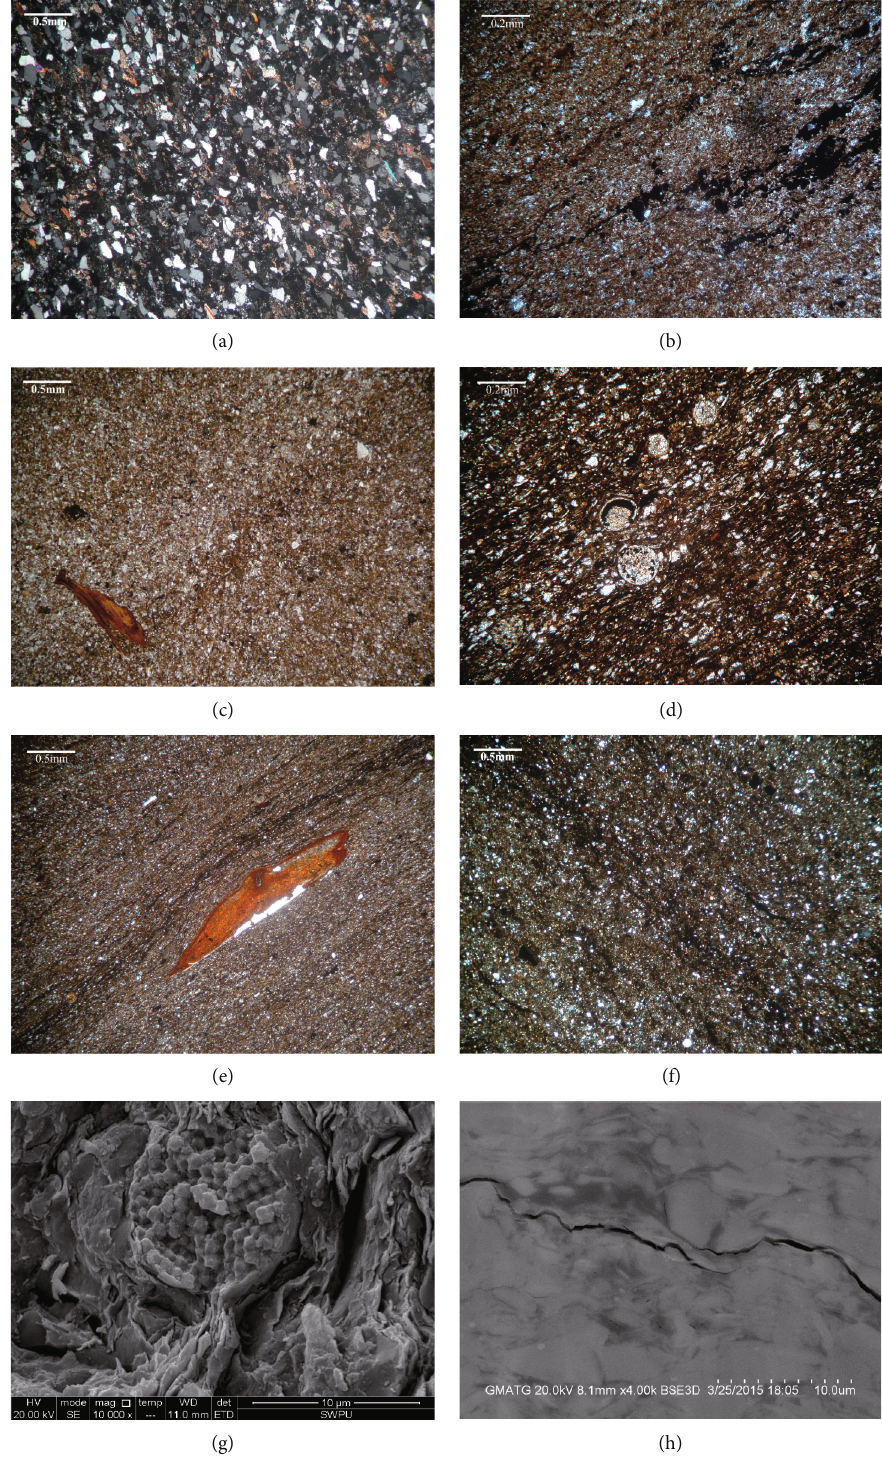
Figure 4: The photomicrographs of Chang 8 and 7 3 intervals in well DP1. (a) Fine-grained sandstone in the 6 th roundtrip. (b) Organic matter occurred along bedding in the 5 th roundtrip. (c – e) Biodetritus including phosphorus and spherical fragments in the 1 st to 5 th roundtrips. (f) Horizontal bedding in the 1 st roundtrip. (g) Framboidal pyrite with a size less than 7 μ m in the Chang 7 3 interval. (h) Tiny cracks in the Chang 7 3 black shale. Note that (g – h) are obtained under scanning electron